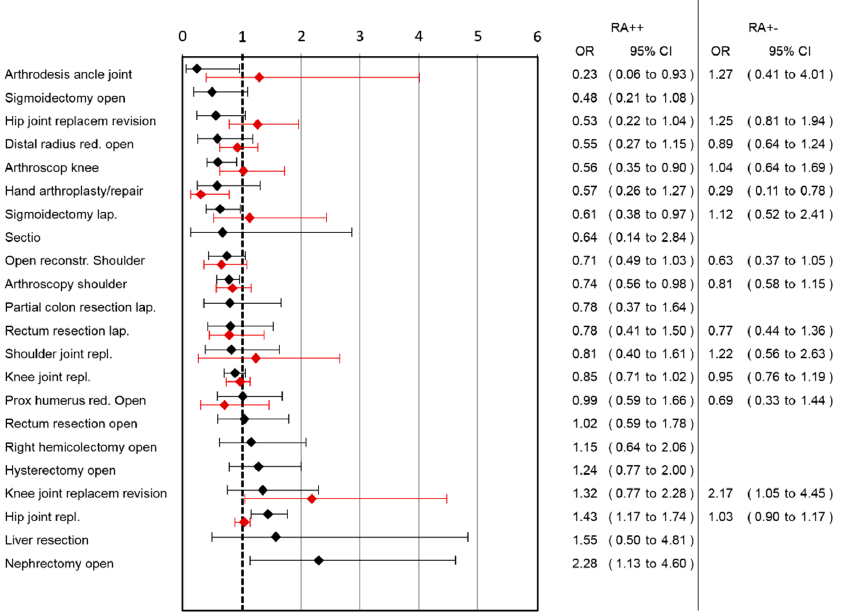
Figure 3. Association of RA with nausea in different surgical categories. Patients with continuous (RA++; black lines) or single-shot RA (RA+ − ; red lines) are compared to patients without RA (RA −− ). OR and corresponding 95% confidence intervals for both analyses are shown.